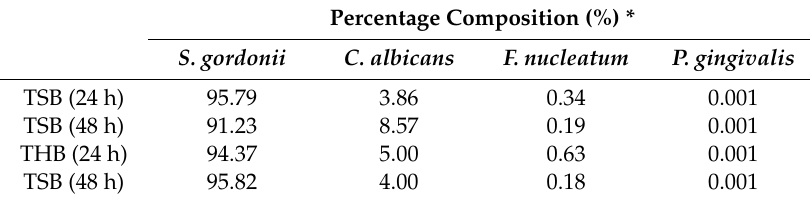
Table 2. Percentage composition of the mixed-species biofilm model.